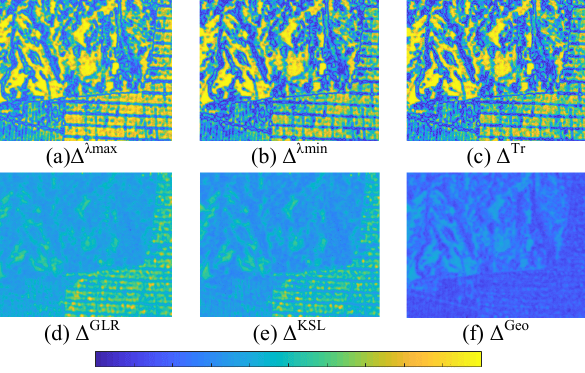
Figure 3. similarity of the image to the specified target B